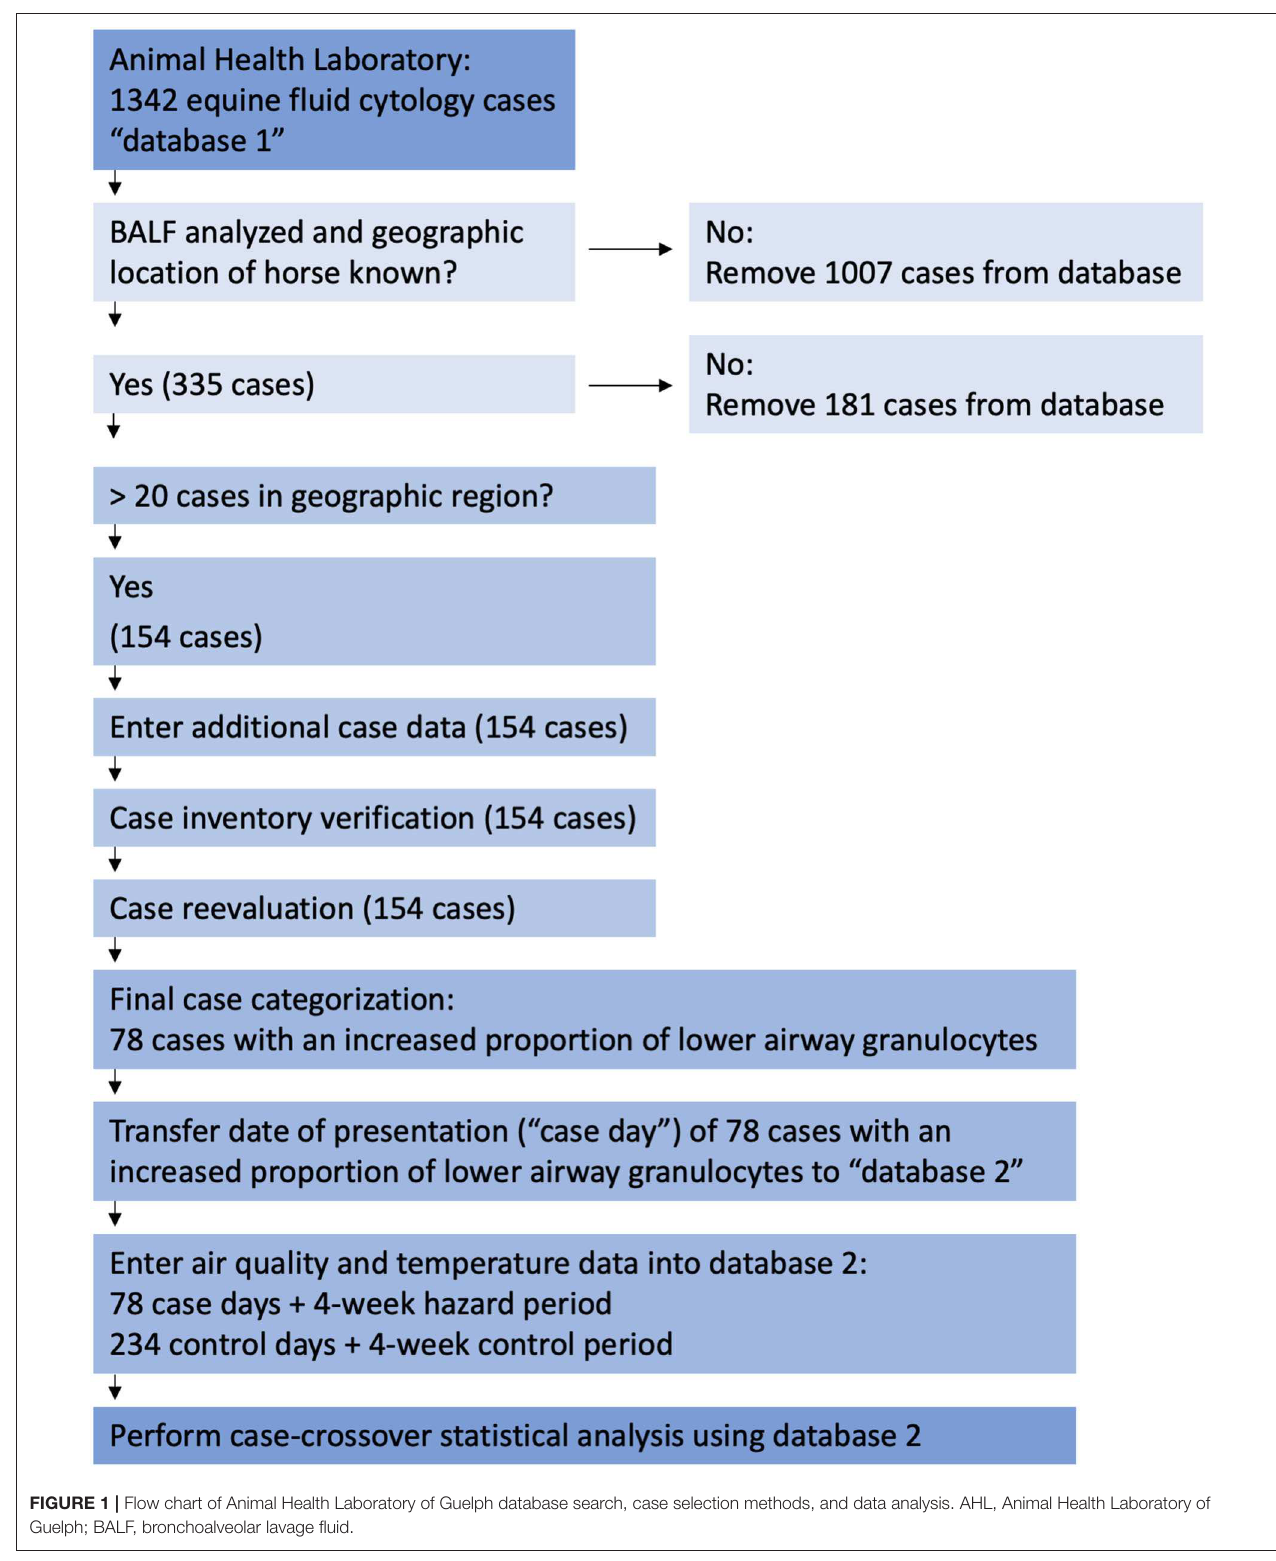
FIGURE 1 | Flow chart of Animal Health Laboratory of Guelph database search, case selection methods, and data analysis. AHL, Animal Health Laboratory of Guelph; BALF, bronchoalveolar lavage fluid.